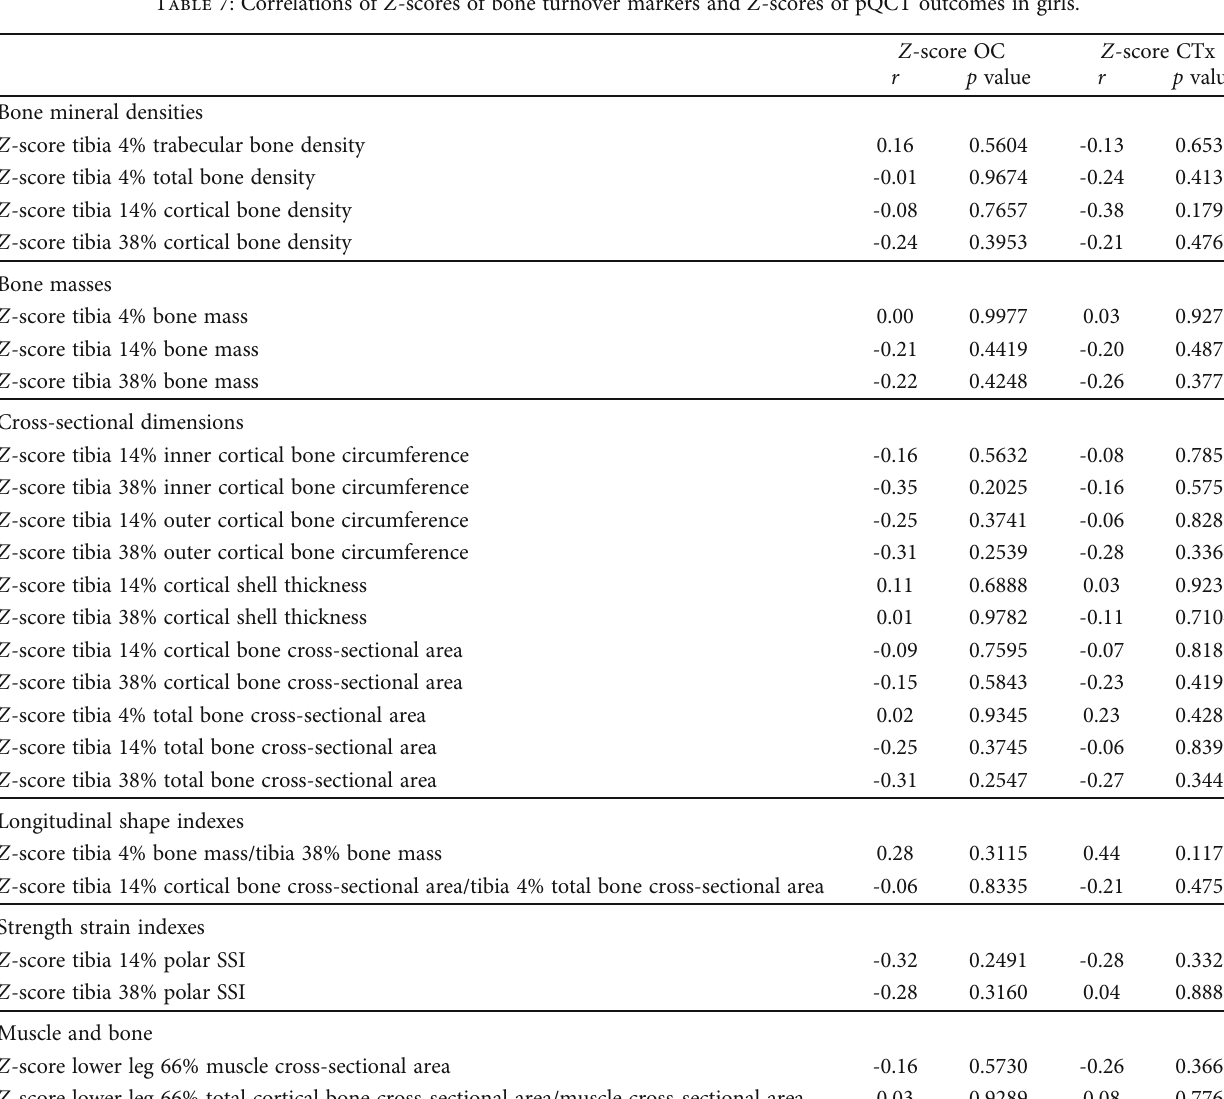
Table 7: Correlations of Z -scores of bone turnover markers and Z -scores of pQCT outcomes in